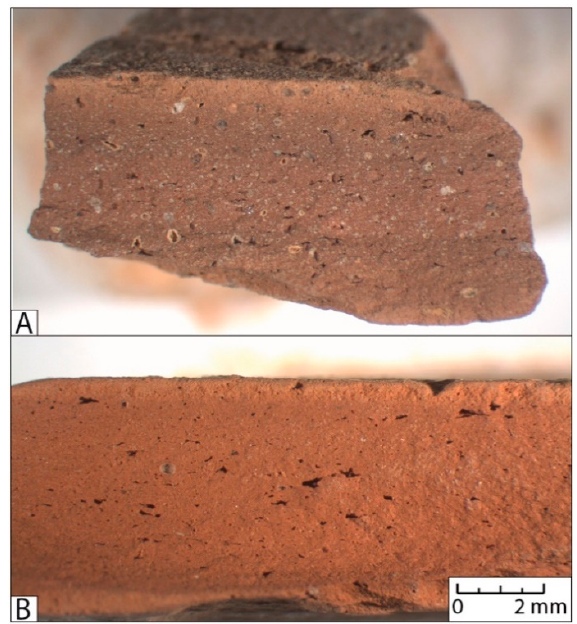
Figure 2. Archaeological fabrics of western Greek amphorae produced in Himera. ( A ) Him-A-1: M 179/160; ( B ) HIM-A-2: M 179/234.